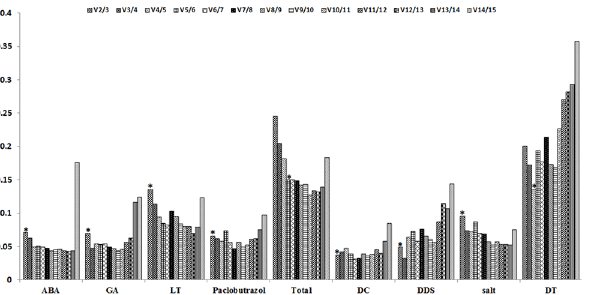
Fig 5. Gene expression pairwise variation (V) of the candidate RGs calculated by geNorm. Pairwise variation (V n /V n+1) was analyzed between the normalization factors NF n and NF n+1 . Asterisk indicates the optimal number of RGs required for normalization. ABA (abscisic acid stress), GA 3 (gibberellin stress), LT (low temperature), Paclobutrazol (paclobutrazol stress), Total (total samples), DC (different cultivates), DDS (different development stages), Salt (salt stress), DT (different tissues).